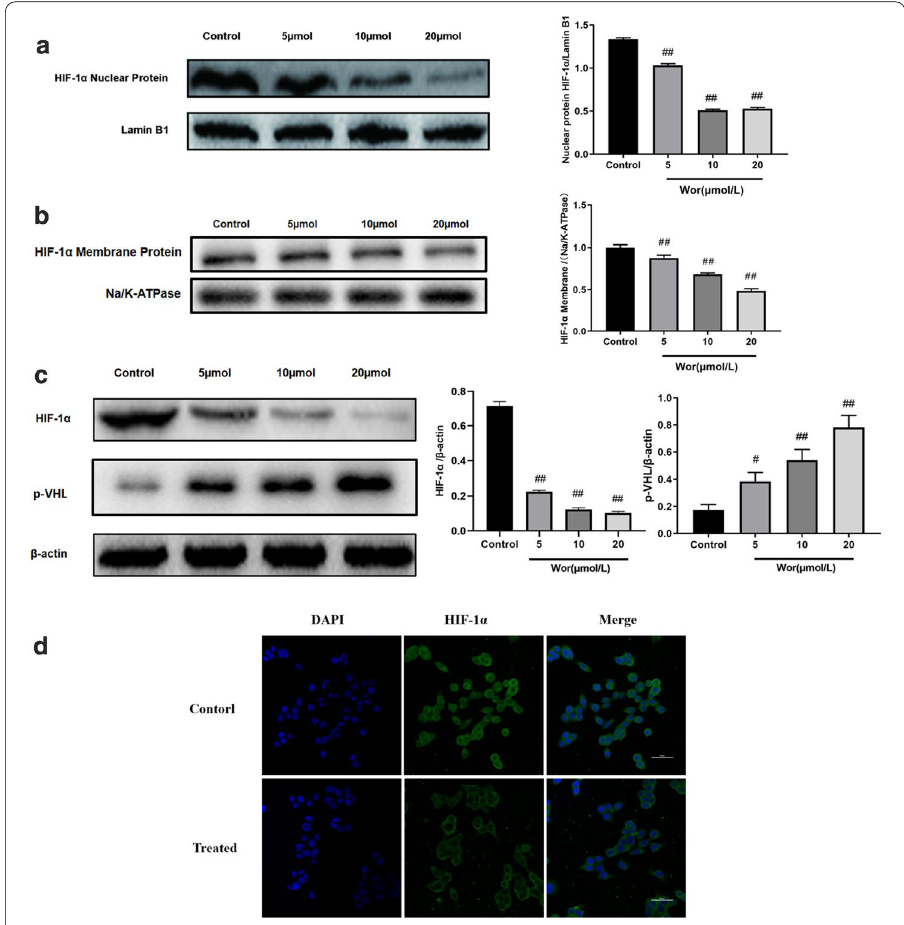
Fig. 4 Worenine promotes the degradation of HIF-1α and inhibites HIF-1α entry into the nucleus. HCT116 cells were treated with various concentrations of worenine (5, 10 and 20 μM) for 24 h. a The effect of worenine on nuclear HIF-1α expression in cells was investigated via western blotting analyses of nuclear protein extracts. b The effect of worenine on membrane HIF-1α expression in cells was investigated via western blotting analyses of membrane protein extracts. c After treatment with a protein synthesis inhibitor, the protein expression levels were determined using western blotting. d Immunofluorescence staining of HIF-1α with or without worenine. The nucleus of the HCT116 cells was stained by DAPI. The data are means SEM. # p < 0.05, ## p < 0.01 vs. control ±